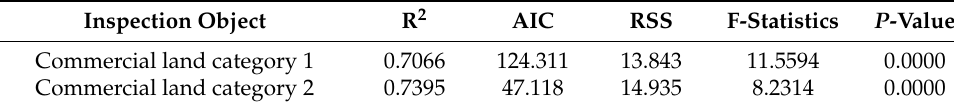
Table 9. OLS model statistical diagnostic table of Commercial subdivision.